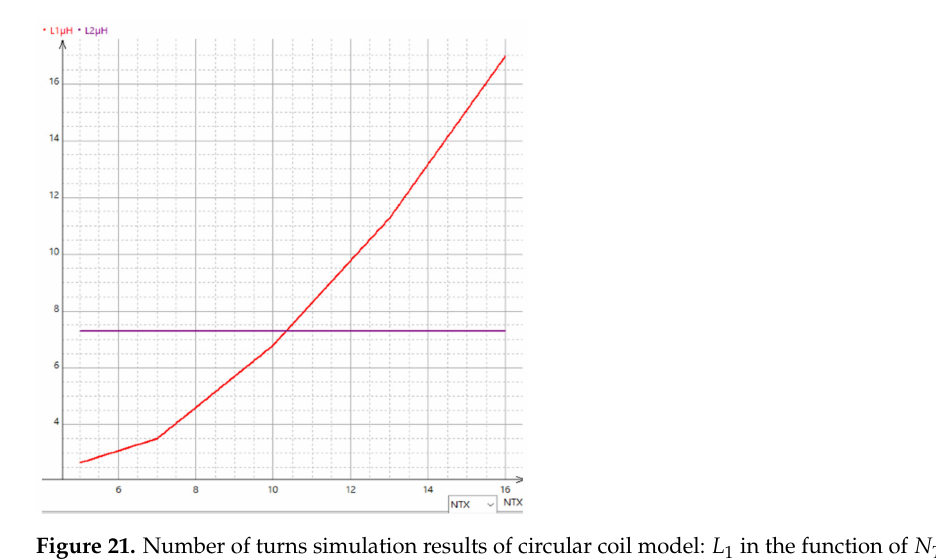
Figure 20. Number of turns simulation results of circular coil model: k in the function of N TX , M in the function of N TX .